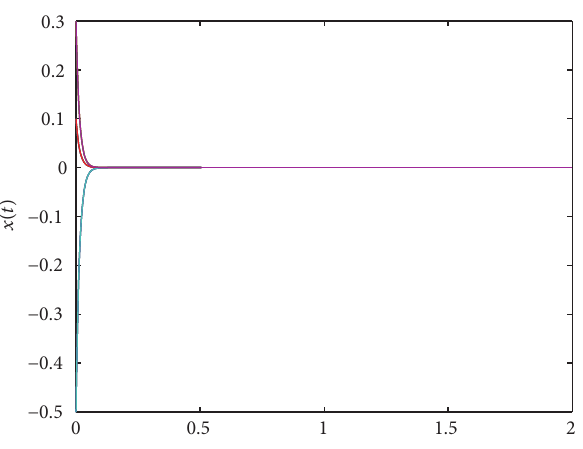
Figure 2: The state response of the closed-loop system by controller (11).